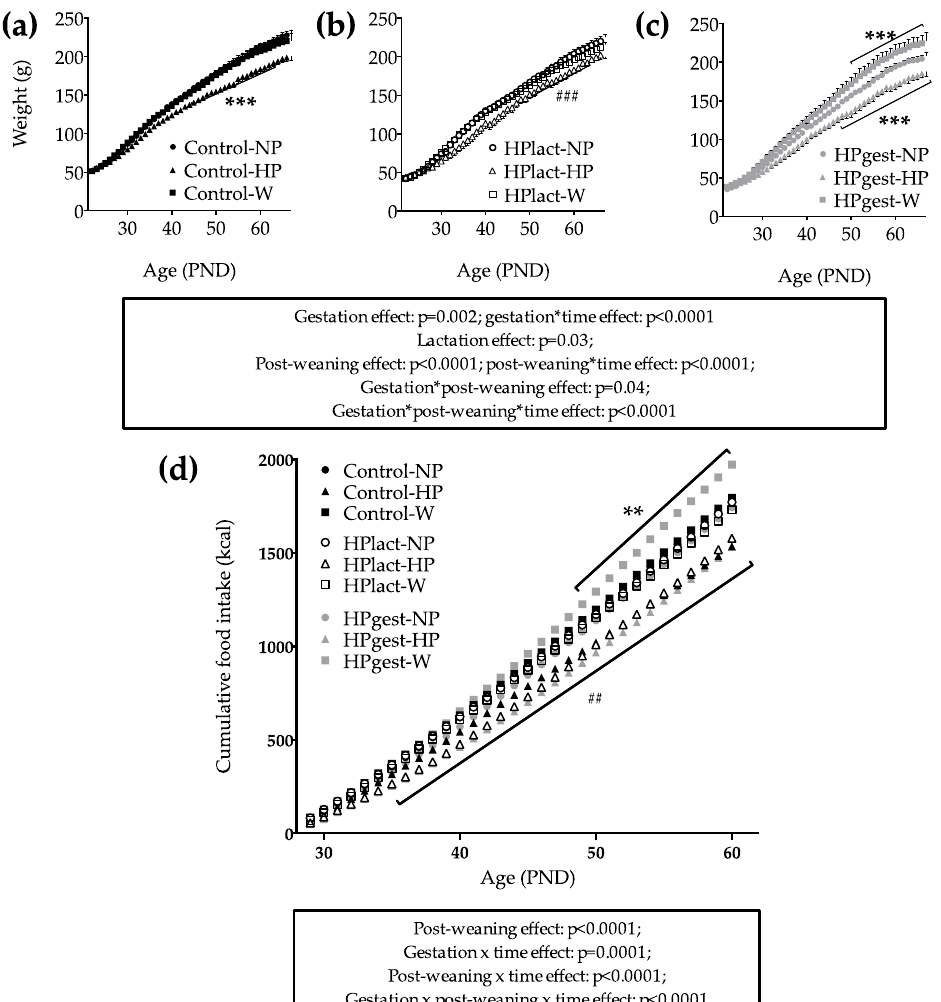
Figure 2. Body weight of the female rat pups of the Control group ( a ), the HPlact group ( b ) and the HPgest group ( c ) from PND21 to PND68 and cumulated food intake of the female rat pups after weaning ( d ) Data are presented as means ± SEM ( n = 8). Effects of diets, time and their interactions were tested within mixed Model 2. *** indicates that the group is significantly different from the others of the graph, ### means that the group is significantly different from the HPlact-NP group. ## Post-weaning HP diet groups are significantly different than the others. ** HPgest-W is significantly different of HPgest-NP .